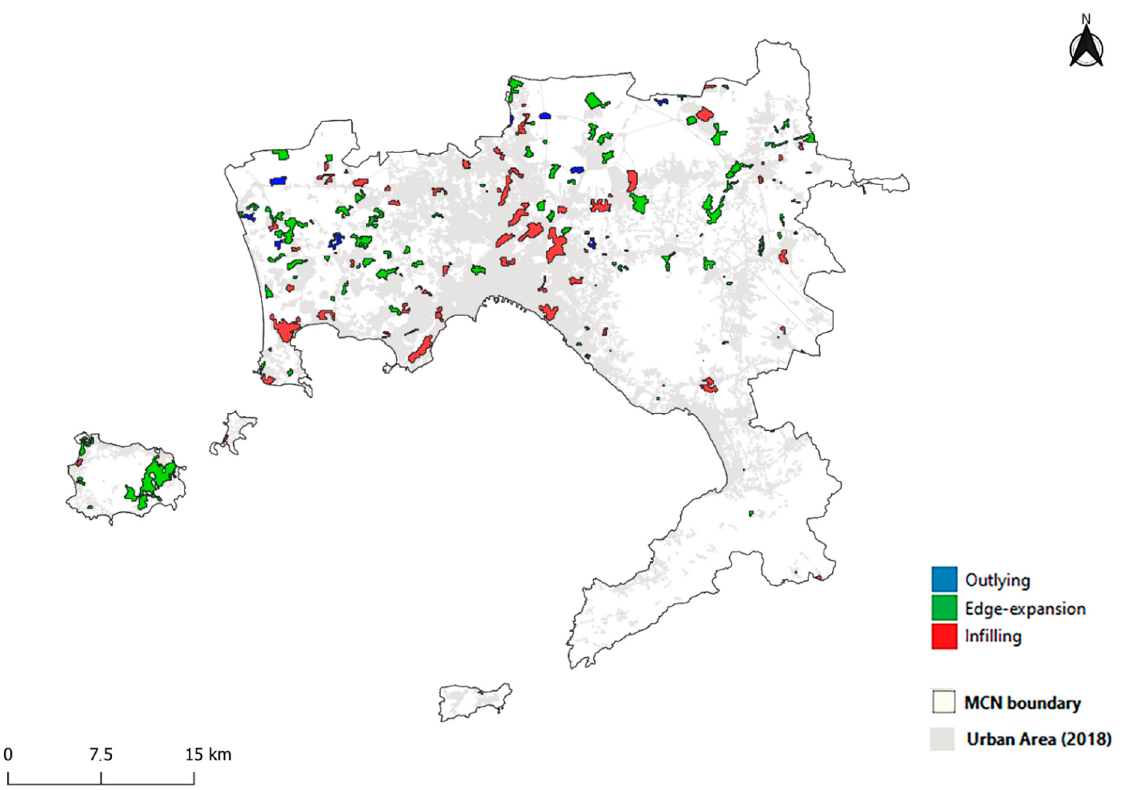
Figure 3. Spatial occurrence of outlying, edge-expansion, and infilling types of fragmenting expansion over the 1990–2018 timeframe in the Metropolitan City of Naples (MCN), southern Italy.